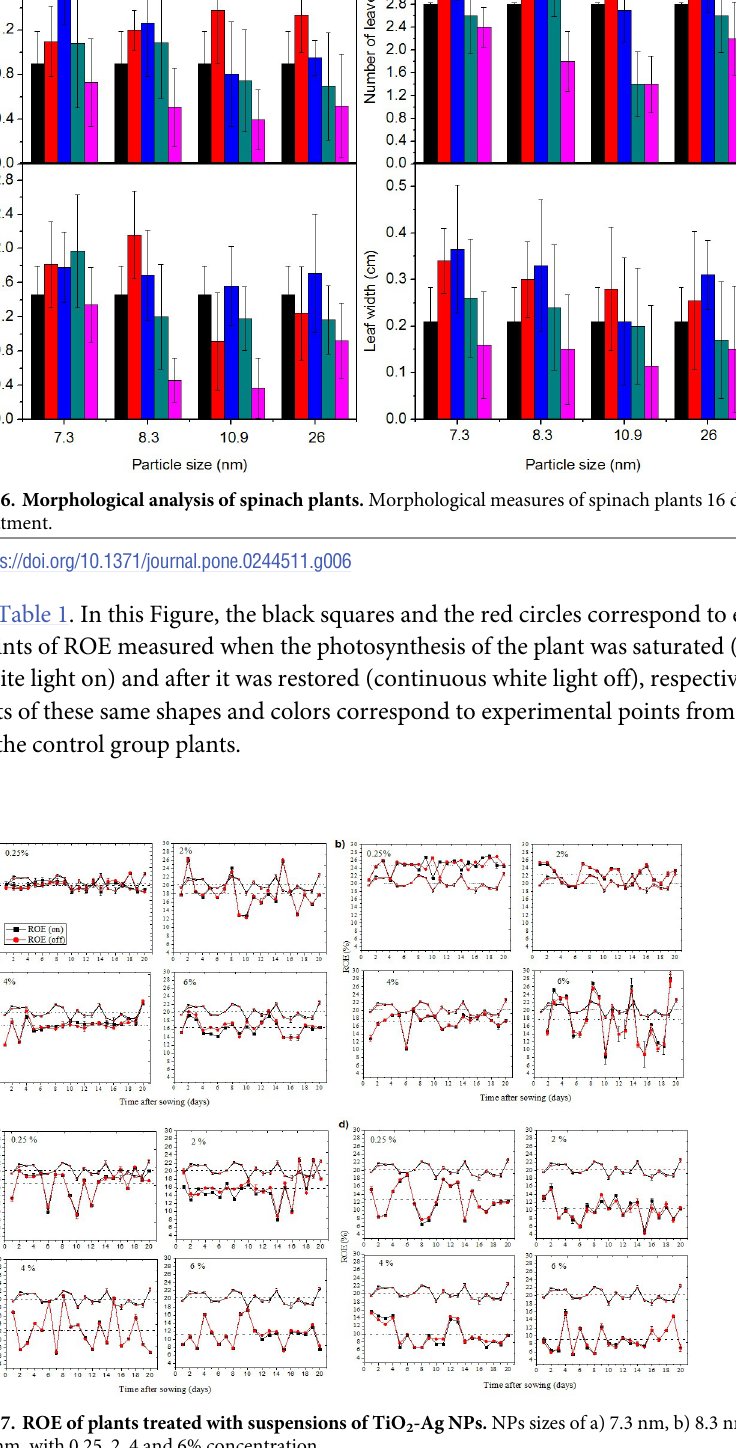
Fig 7. ROE of plants treated with suspensions of TiO 2 -Ag NPs. NPs sizes of a) 7.3 nm, b) 8.3 nm, c) 10.9 nm and d) 26 nm, with 0.25, 2, 4 and 6% concentration.